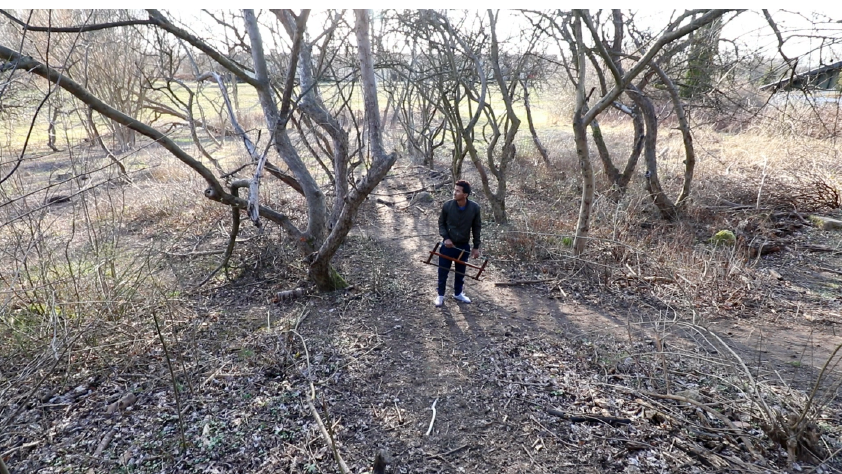
Figure 23. Shirak is making a scene for the film where he search for a branch to create a slingshot. When he lived in Asmara, he used to hunt pigeons with his homemade slingshot. He would sneak up close to them, and hurl a stone at their wings and thus catch them. He would bring them back and sell them at the market. In this way, he would earn money to spend in the evening at an internet cafe with his friends. March 2017.